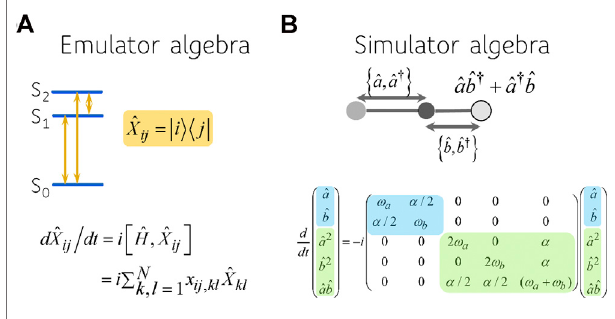
FIGURE 2 | The algebra characterizing the device (A) and the physical system (B) . The coherences X ij (cid:1) | i 〉〈 j | between excited levels i and j of the quantum dot dimer are our logic variables. After the laser pulses are over, the coherences oscillate in time with a frequency that is the difference between the energies of the two states that they connect. We aim to simulate the time dependence of observables of the coupled oscillators system. For example, as shown in Eq. 7 , we need the time dependence of 〈 a 2 〉 to compute the variance of the bond displacement of the fi rst